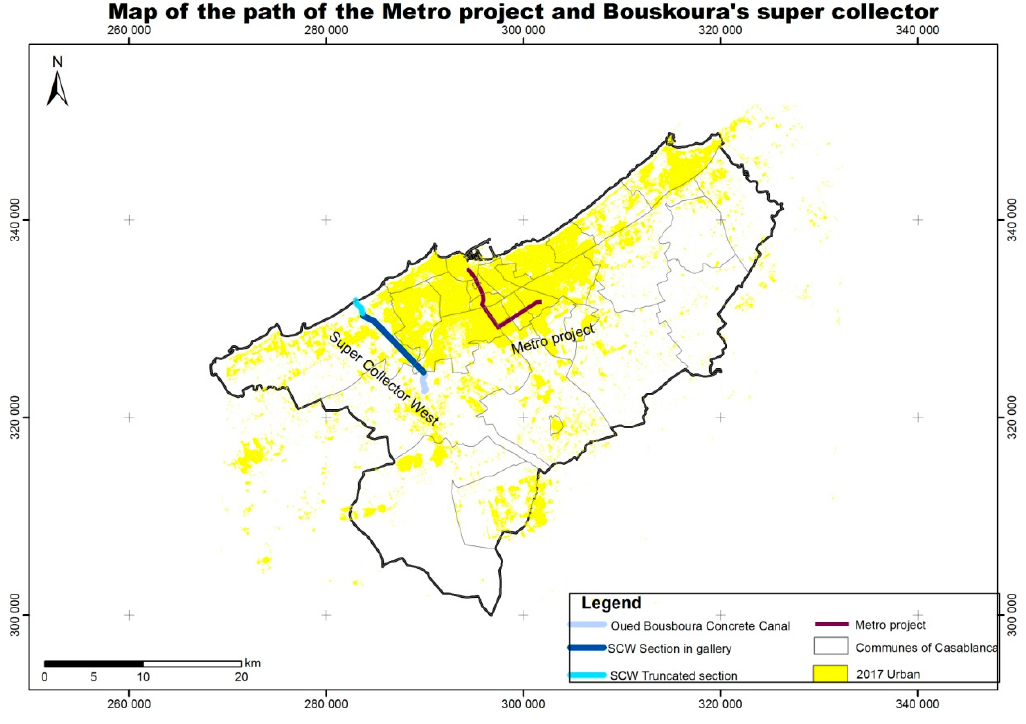
Figure 7. A map of the path of the Metro project and Bouskoura’s super collector.